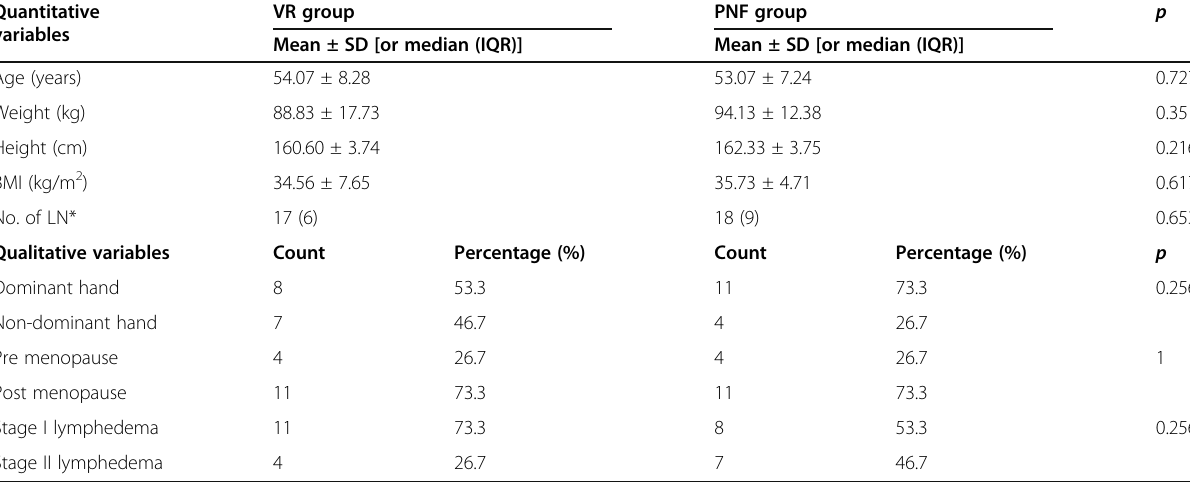
Table 1 Demographic data for the quantitative and qualitative